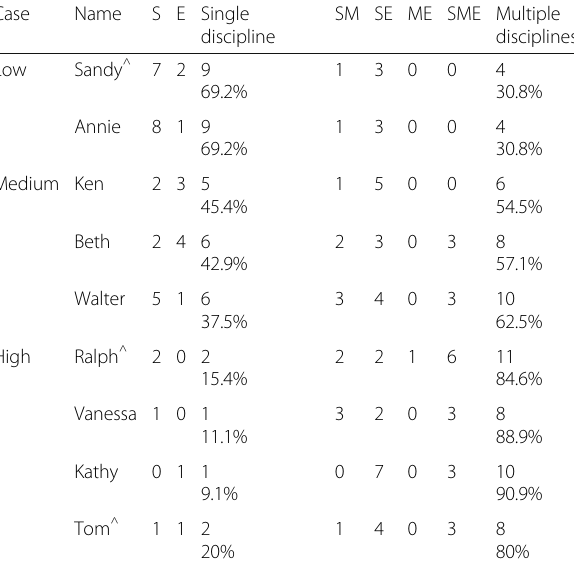
Table 3 Frequency of instructional days featuring single